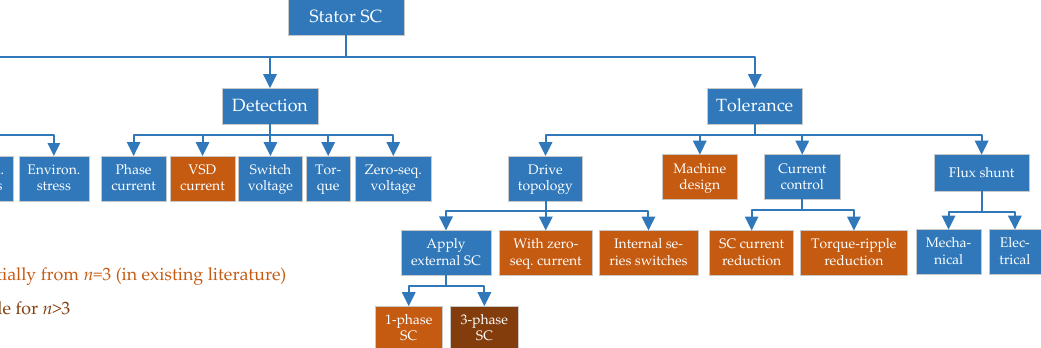
Figure 11. Causes, detection methods and tolerance approaches for stator SC faults in multi- phase